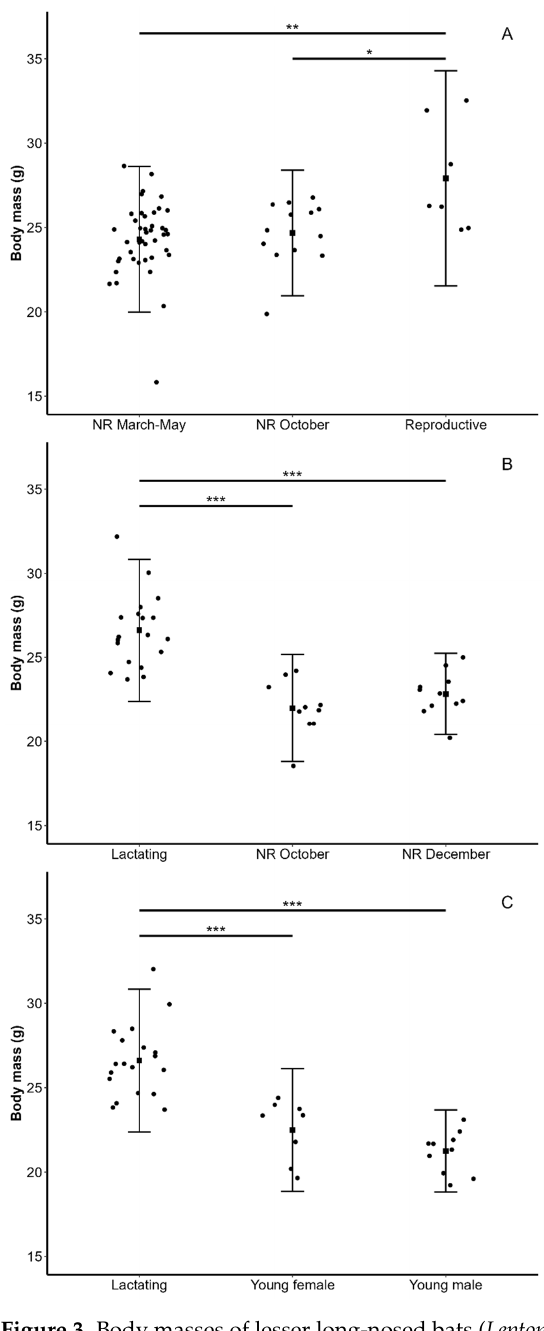
Figure 3. Body masses of lesser long-nosed bats ( Leptonycteris yerbabuenae ) for ( A ) non-reproductive (NR) adult males in March 2019 and 2020 and May 2019 (inguinal or scrotal testicles and no dorsal patches), October 2019 (scrotal testicles and no dorsal patches), and reproductive males in December 2019 (males with scrotal testicles and fresh dorsal patches) captured in west-central Mexico; for ( B ) lactating females captured in northern Mexico in May and July–August 2019 and adult females with no apparent signs of pregnancy or lactation (NR) captured in west-central Mexico in October and December 2019; and for ( C ) lactating females and young males and females captured in northern Mexico in July–August 2019. Pregnant females captured in northern Mexico were not included in the comparison because their body mass included the mass of the fetus. Values are means ± standard deviations. Significant differences in pairwise comparisons are shown ( p ≤ 0.05 *, p ≤ 0.01 **, p ≤ 0.001 ***) based on a general linear model with a lognormal